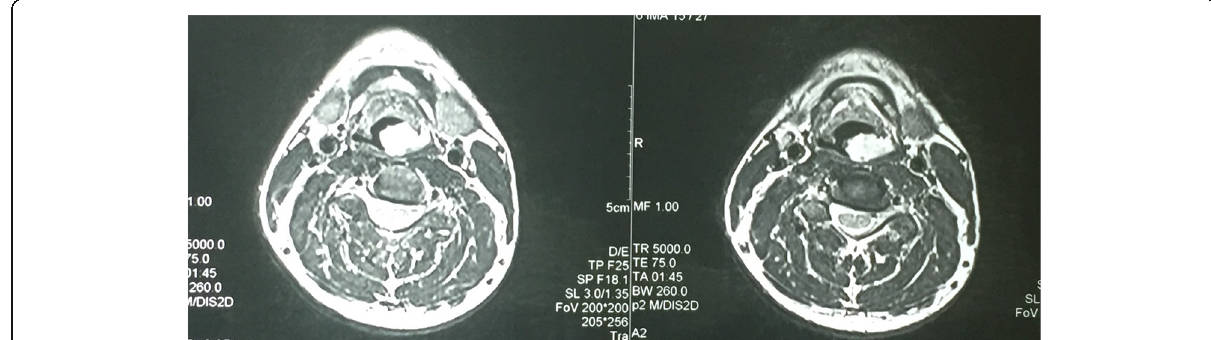
Fig. 2 MRI showing an intensely enhancing lesion in the left